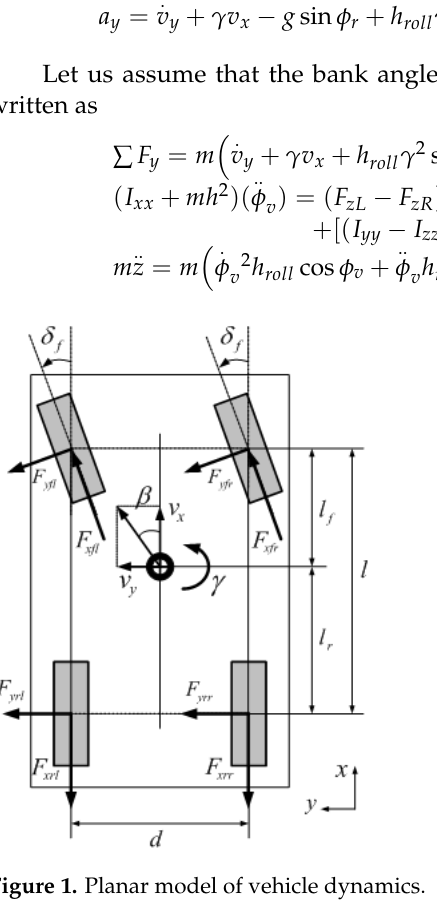
Figure 2. Roll model of vehicle dynamics. 2.3. Lateral-Acceleration-Based LTR With a steady state assumption(